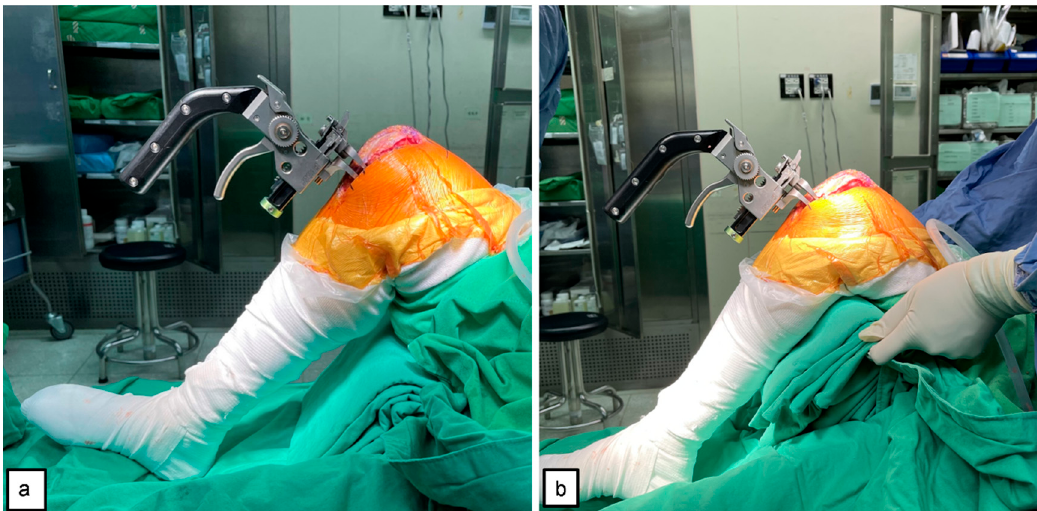
Figure 3. The flexion gap being measured by the tensioner: ( a ) closed-chain flexion gap (Fc gap) of the knee at 90° flexion without thigh support and the foot placed on the operating table; ( b ) open-chain flexion gap (Fo gap) of the knee at 90° flexion with thigh support and the foot suspended off the table.